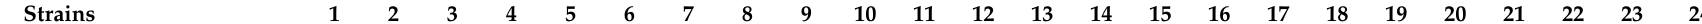
Table 1. Sequence similarity comparison of the 16S rRNA gene between Microcoleusiopsis ganfuensis strains and its closed species and genera. Similarity = [1 − (p-distance)] * 100. Strains 1